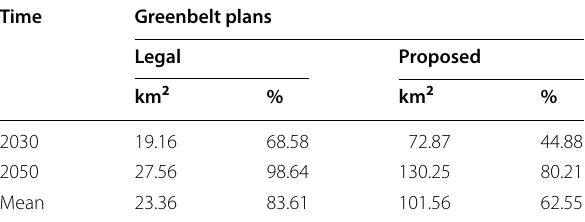
total scores for opportunity and threat factors were esti- mated equal to 1.90 and 0.75, respectively. A total sum